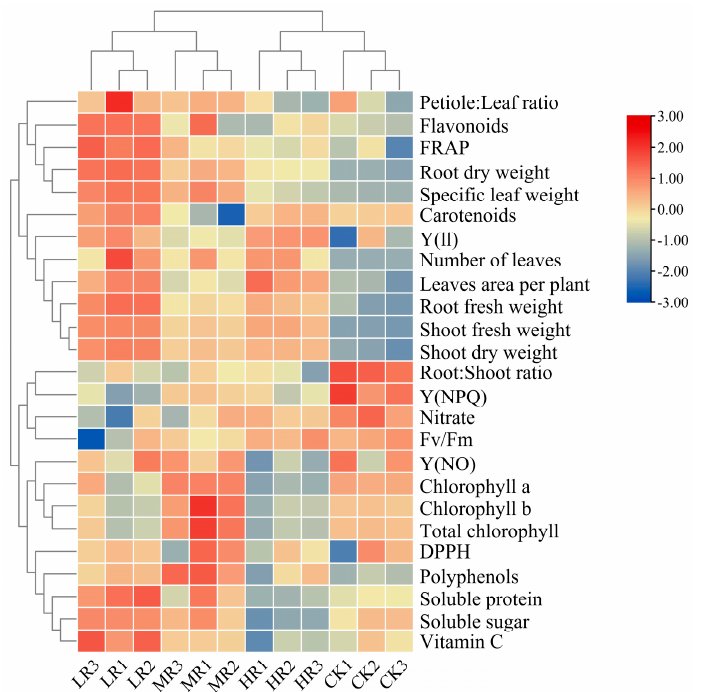
Figure 7. CK: only white light, LR: red:white = 1:2, MR = red:white = 1:1, LR = red:white = 2:1. Cluster heat map analysis of pak choi grown under the different ratios of red and white light treatments. Results are visualized using a false-color scale, with blue indicating a decrease and red indicating an increase in the response parameters.